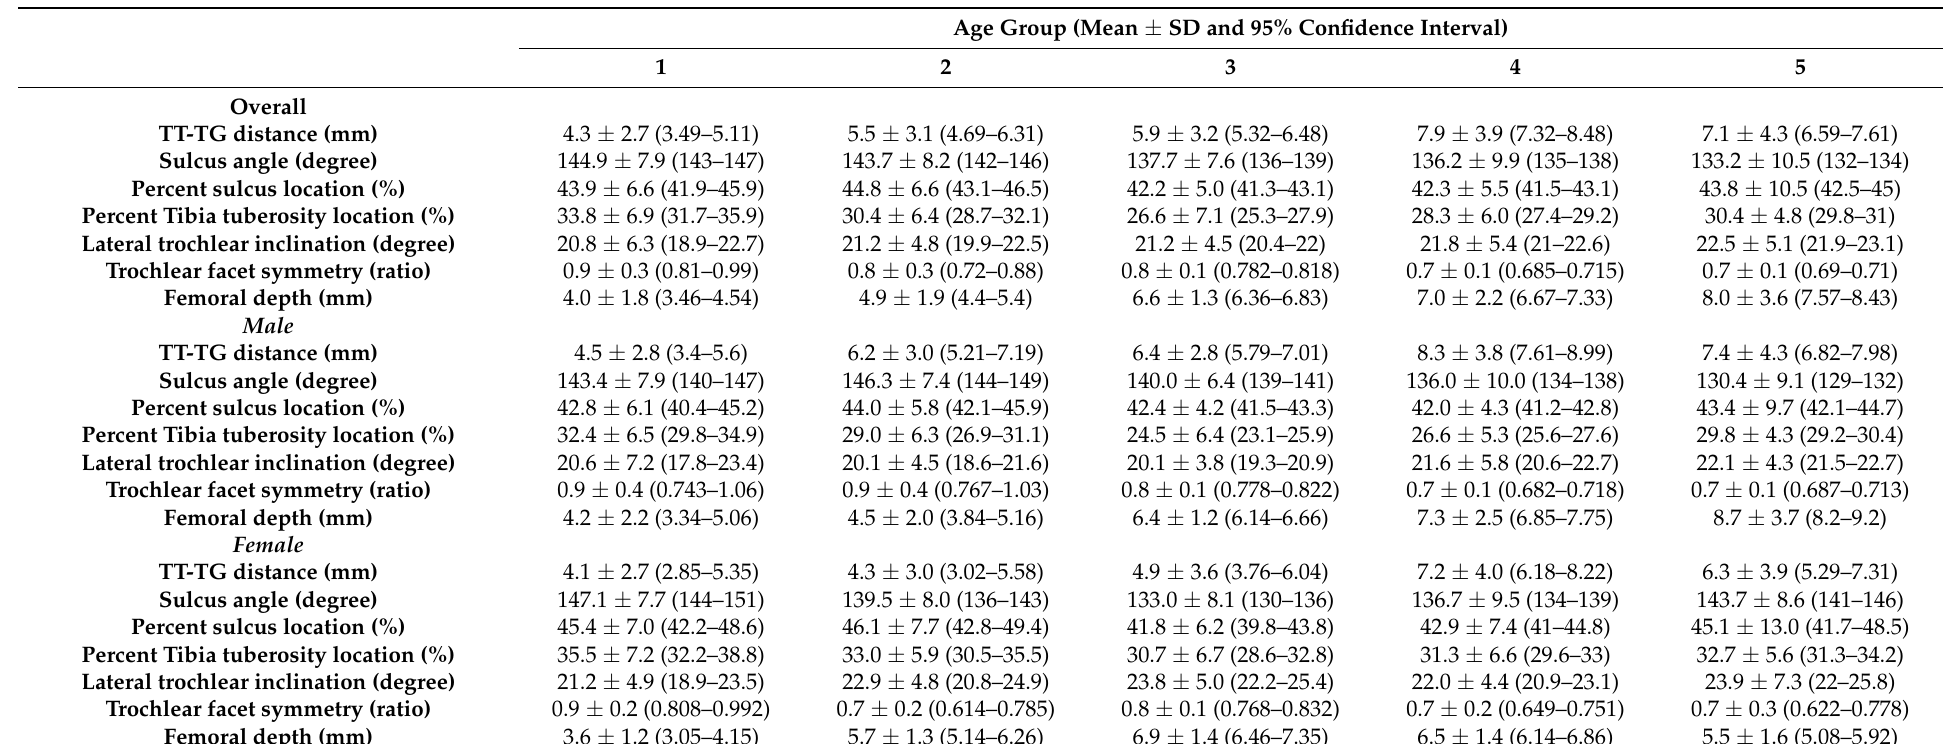
Table 2. Patellofemoral Morphological